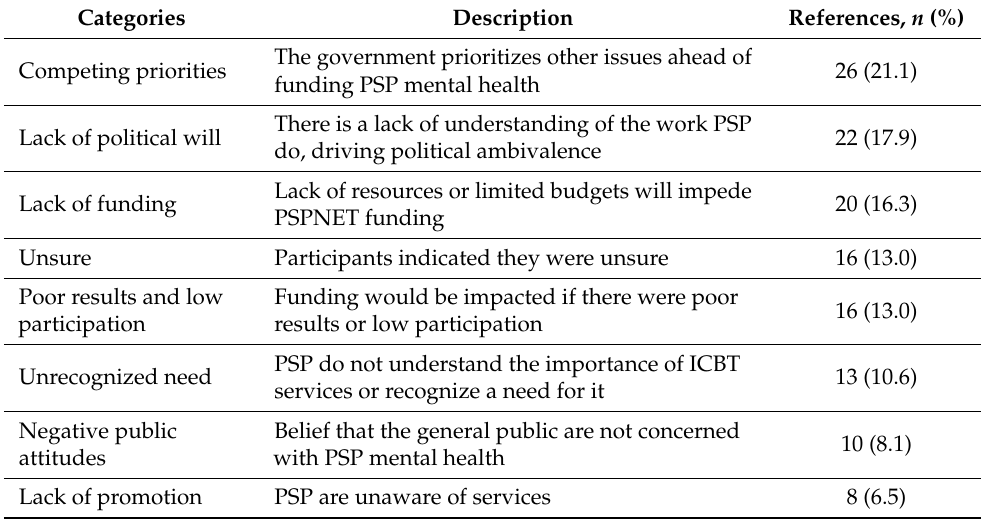
Table 8. Perceptions of barriers for obtaining more funding for PSPNET ( n =